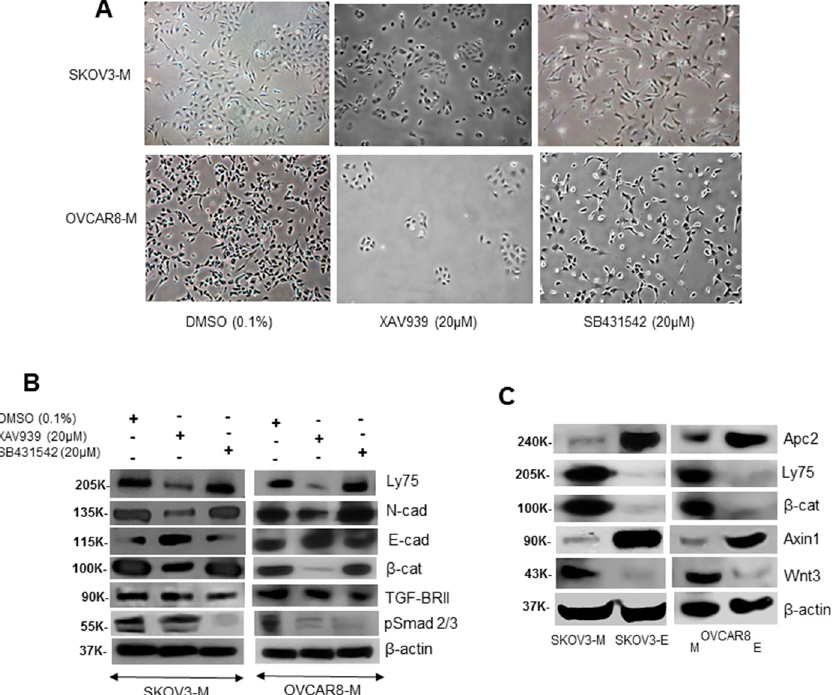
Figure 4. ( A ) Representative images of SKOV3-M and OVCAR8-M (parental) cells upon XAV939, SB431542, or DMSO (control) treatment. ( B ) Western blot analysis of Ly75, β -catenin, TGF-B-RII, p-Smad2 / 3, E-cadherin, and N-cadherin expression levels in SKOV3-M and OVCAR8-M cells upon treatment with the Wnt / β catenin inhibitor XAV939, the TGF- β inhibitor SB431542, and DMSO (control treatment). ( C ) Western blot analysis of the expression levels of di ff erent members ( β -catenin, Axin1, Apc2, and Wnt3) of the Wnt / β catenin pathway in SKOV3-M, SKOV3-E, OVCAR8-M, and OVCAR8-E cells. β -Actin was used as a loading control.